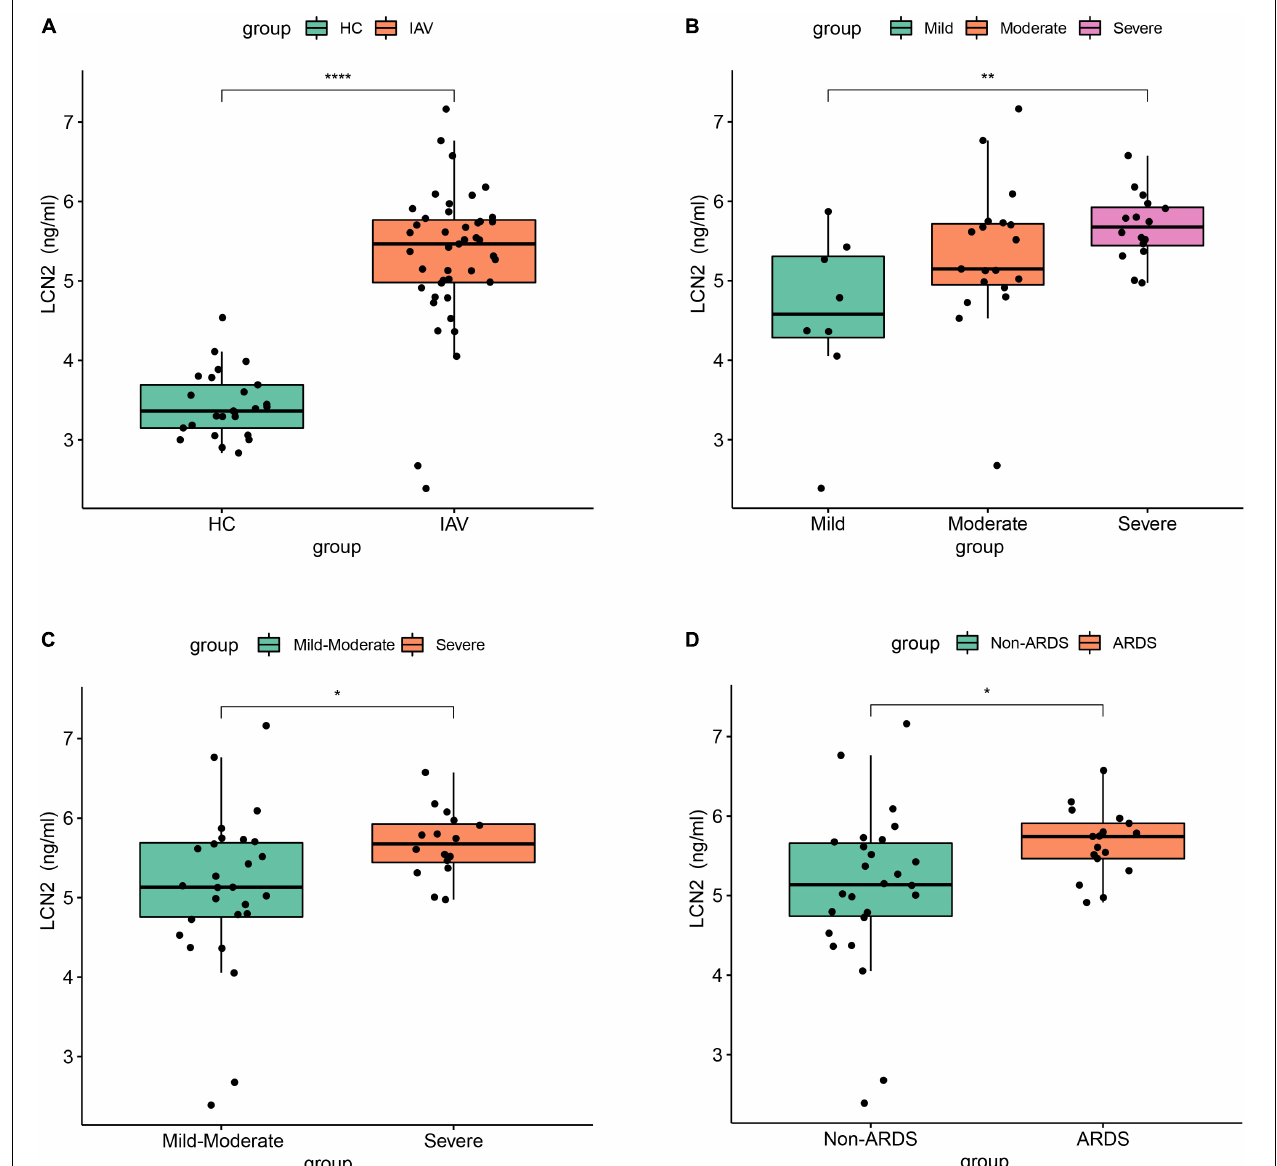
FIGURE 4 | The association between LCN2 and disease severity in clinical patients with IAV infection. (A) Serum LCN2 levels in healthy controls and patients with IAV infection. (B,C) Serum LCN2 levels in patients with mild, moderate, and severe influenza. (D) Serum LCN2 levels in ARDS and non-ARDS patients with IAV